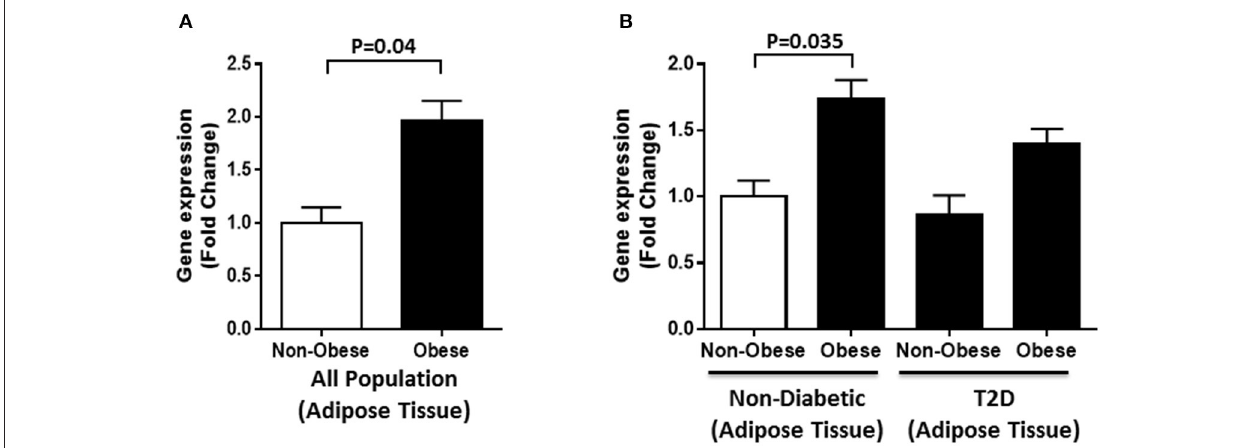
FIGURE 4 | DNAJC27 expression in adipose tissue comparing obese to non-obese individuals . (A) Expression of DNAJC27 in all population ( n = 40). (B) Expression of DNAJC27 in non-diabetic ( n = 20) and in T2D ( n = 20).